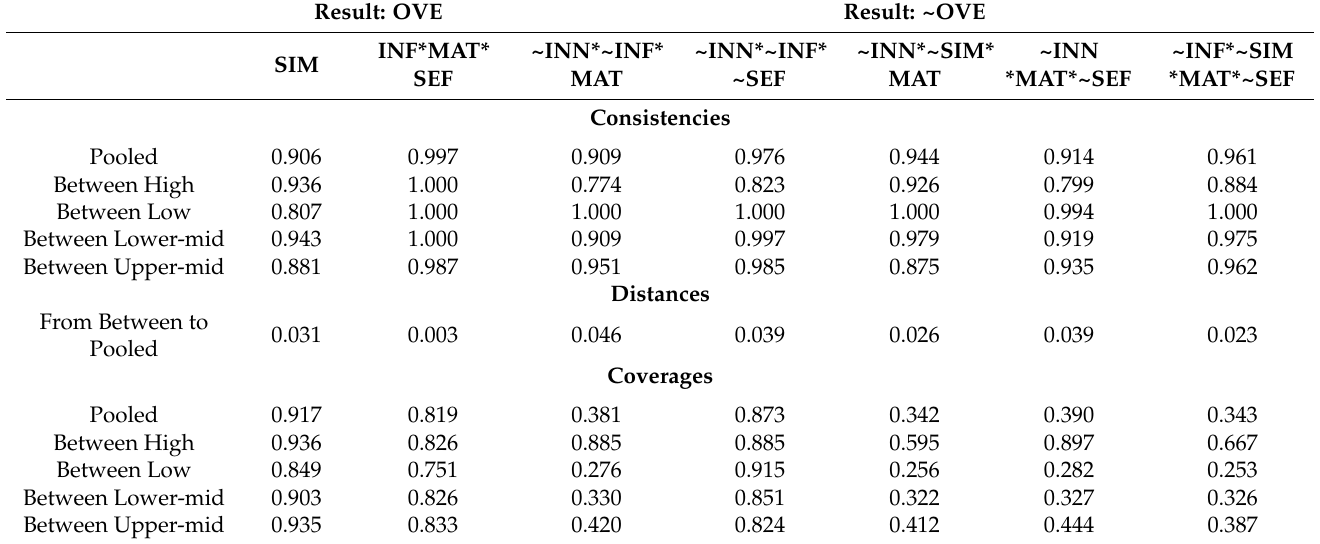
Table 6. Cluster